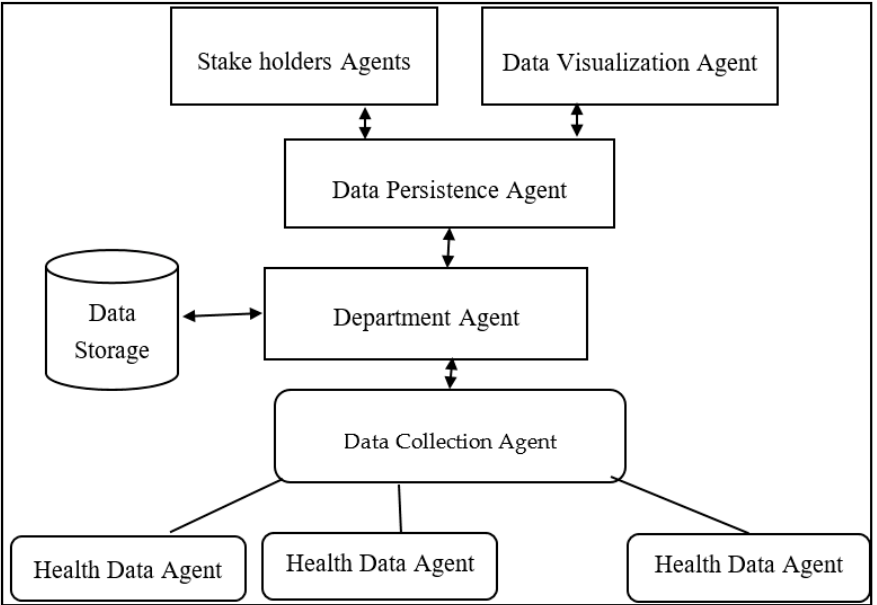
Figure 5. Multiagent architecture of smart city healthcare system in a zone .